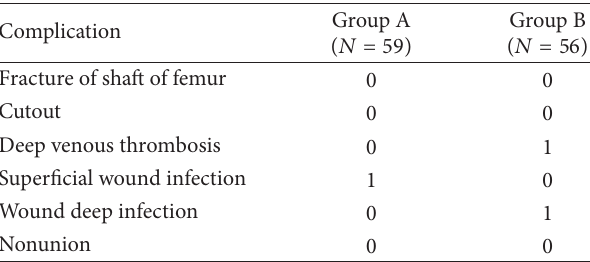
Table 3: Comparison of complication in the lateral decubitus position and supine position groups after